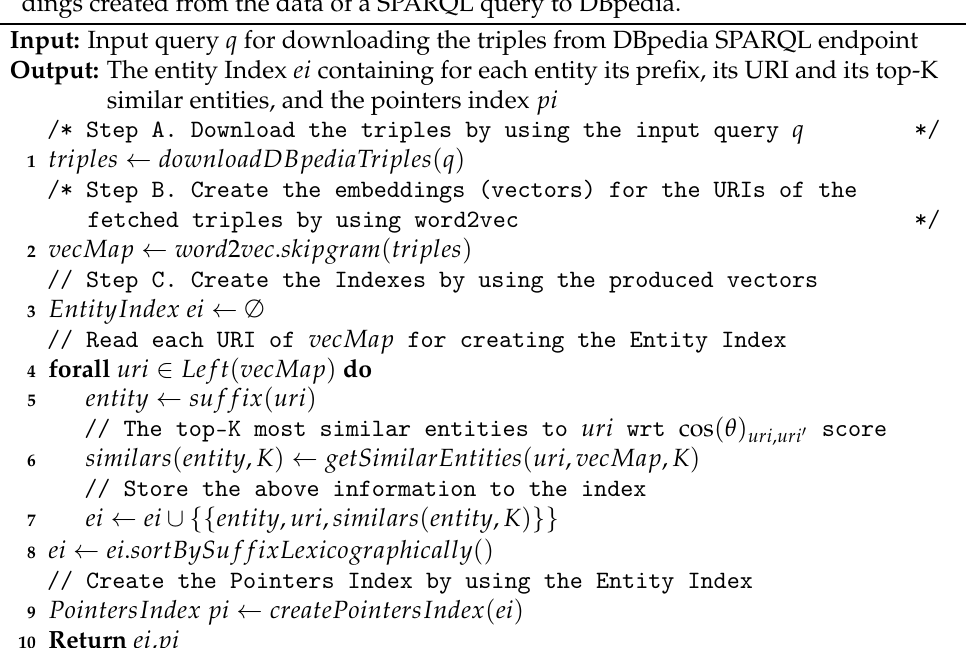
Algorithm 1: Creating the Entity and the Pointers Index, by using the embed- dings created from the data of a SPARQL query to